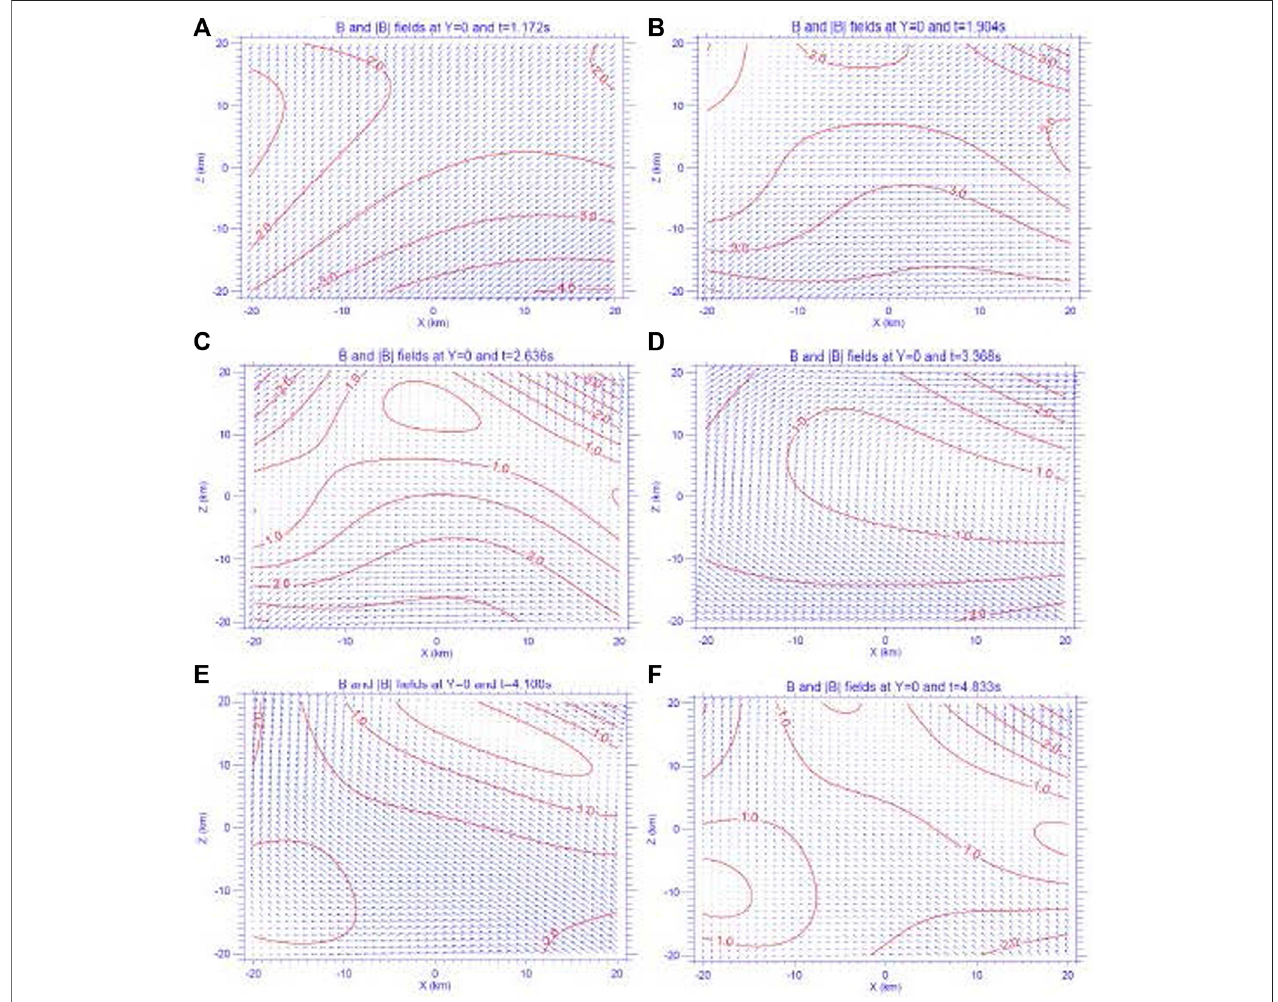
FIGURE8| Modeled B fi eldsprojectedintoand itsmagnitude | B |(in nT)evaluatedonthe X-Z planeof Y =0 atsixtimeinstancesof (A) t (cid:1) 1 . 172 s, (B) t (cid:1) 1 . 904 s, (C) t (cid:1) 2 . 636 s, (D) t (cid:1) 3 . 368 s, (E) t (cid:1) 4 . 100 s, and (F) t (cid:1) 4 . 833 s after 22:34 UT on 11 July 2017.